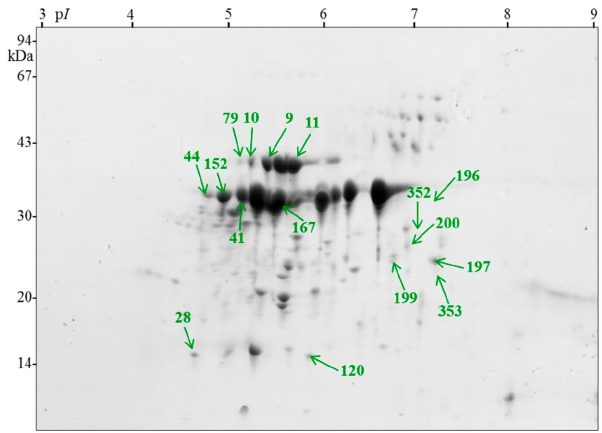
Figure 2. Reference gel demonstrating positions of statistically significantly variable spots from Rosa canina L. between dry seeds (primary dormant), seeds after warming, seeds after the cold phase of stratification (nondormant), and seeds after germination test at 20 °C (secondary dormant). The numbers of identified proteins correspond to those listed in Table 1.